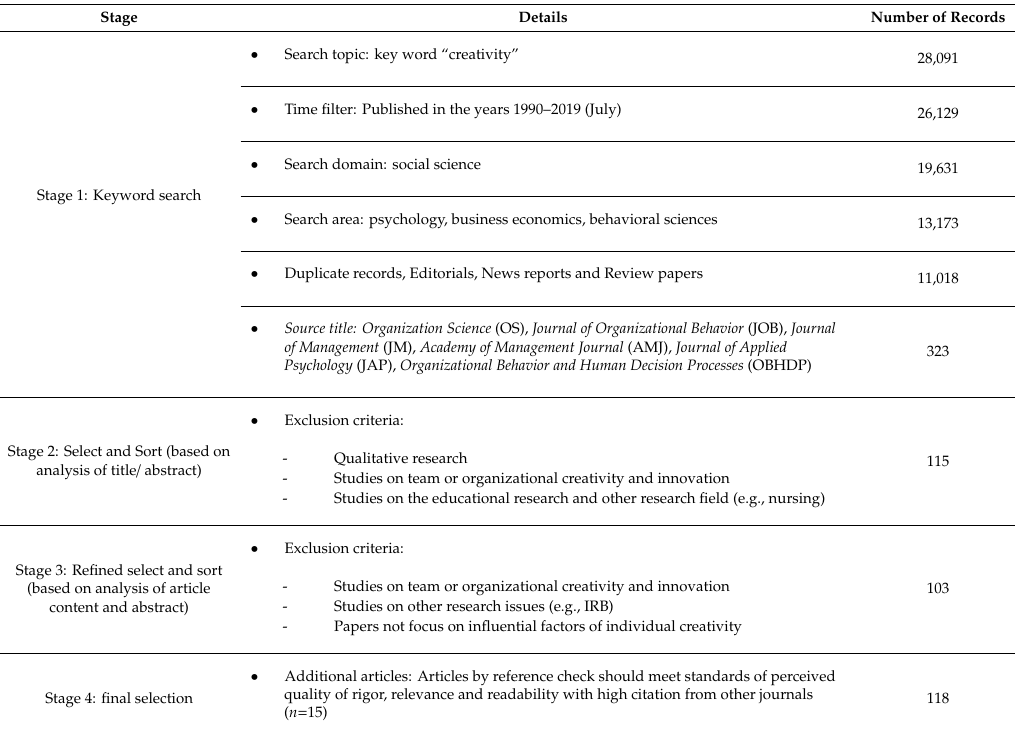
Table 1. Literature Collection